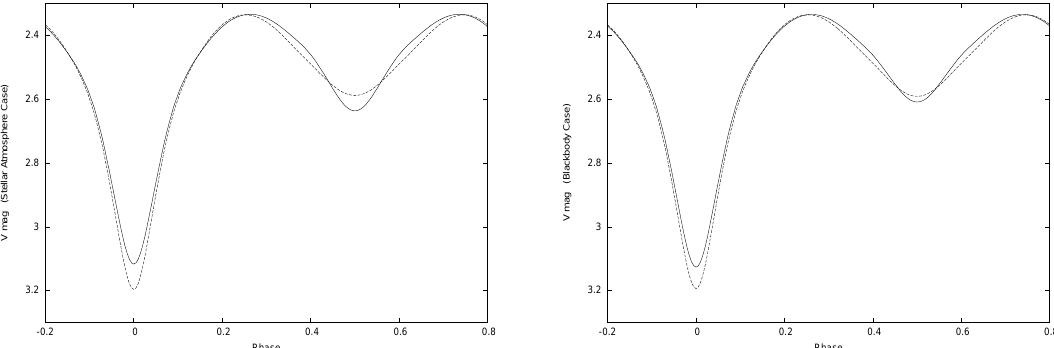
Figure 1. Left panel : V band light curves for model OC binaries of high [16,000; 8000] K (continuous line) and low [8000; 4000] K (dashed line) temperature. All other parameters are the same for the two curves, with limb darkening computed from local physical variables and aspect. The vertical shift between curves is set so that they agree at phase 0.25, since few published light curves are in absolute physical units. T 2 / T 1 = 0.5000 for both curves yet they obviously differ, so no definite light curve corresponds to T -ratio 0.5. Right panel : resulting curves for blackbody emission with all input quantities the same as for the left panel. The high and low T blackbody curves differ but are somewhat closer than the atmosphere curves.